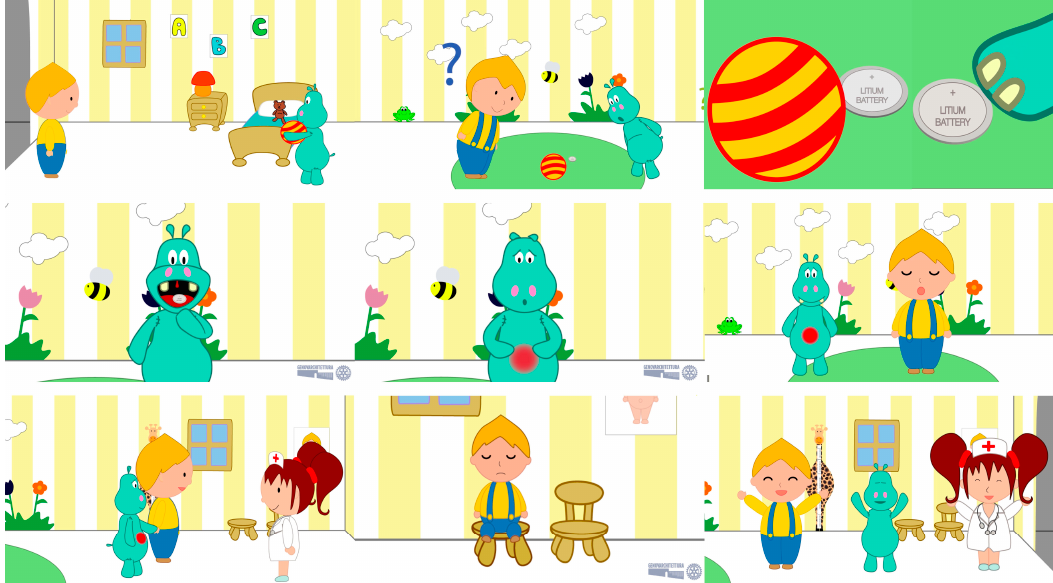
Figure 2. Above . Frames from the project “Le avventure di Filippo e Ippo”. Problem: “home incident” (ingestion of objects). Target: children 3–5 years. Technique: animation; duration 30 s. Visual column: front view and high angle shot for extreme close-up, full length figure and medium shot to emphasize some events. Soundtrack: dialogues and ambience sounds. Authors: A. Covato, S. Pastorino, S. Repetto. Credits in note 3